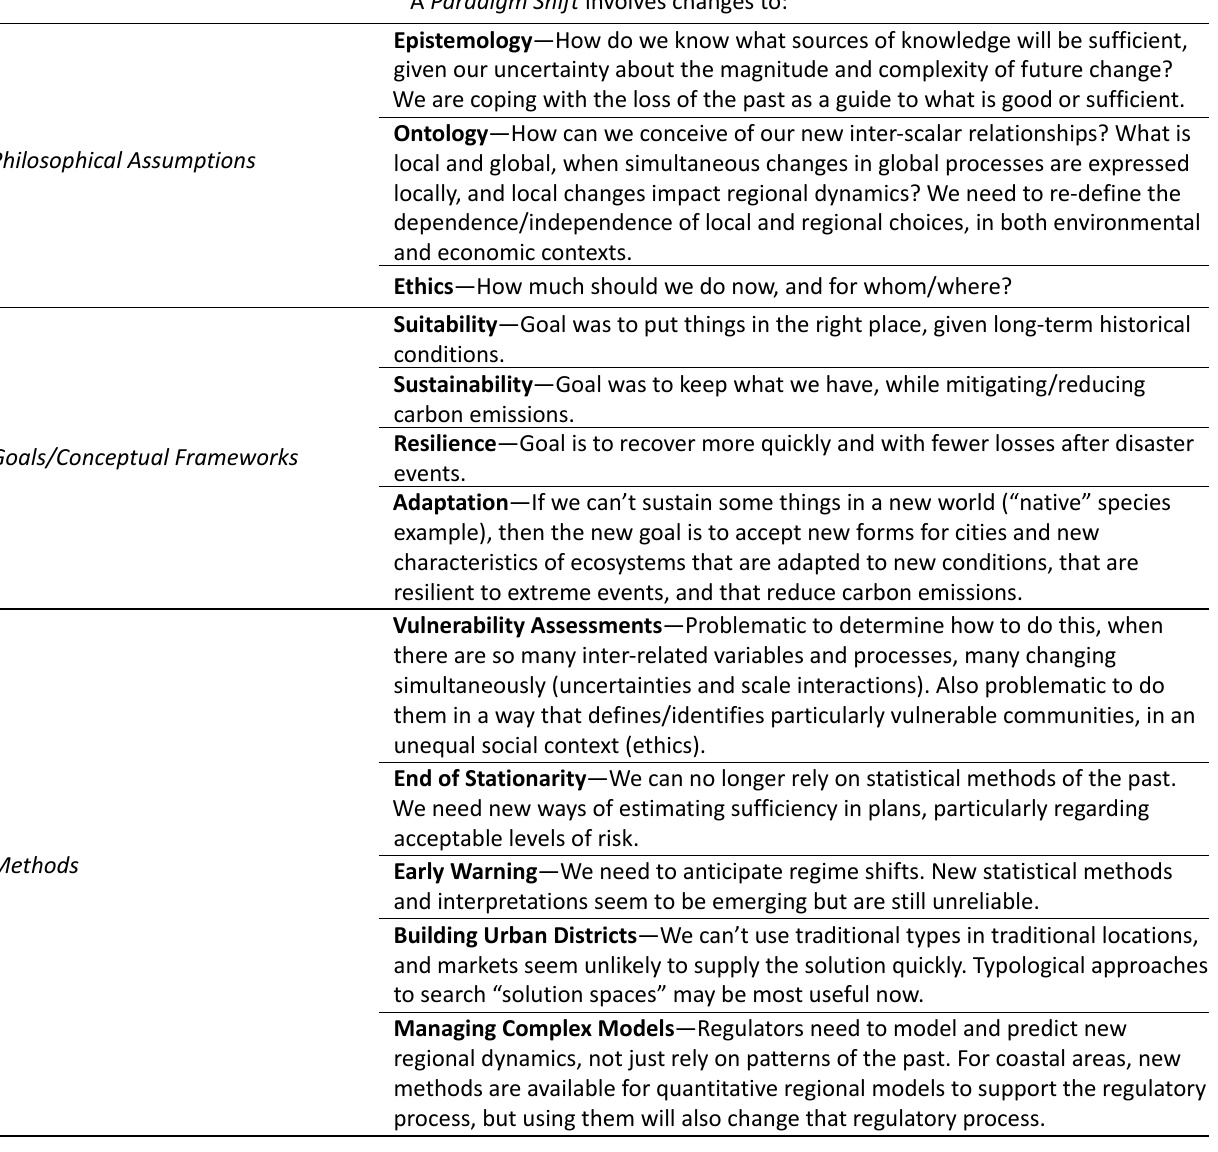
Table 1. Summary of a paradigm shift: how is our encounter with climate change beginning to change